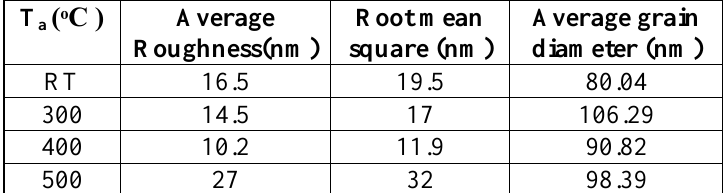
Table 3: Average grains diameter, root mean square, and average roughness for Cr films at different annealing temperature.